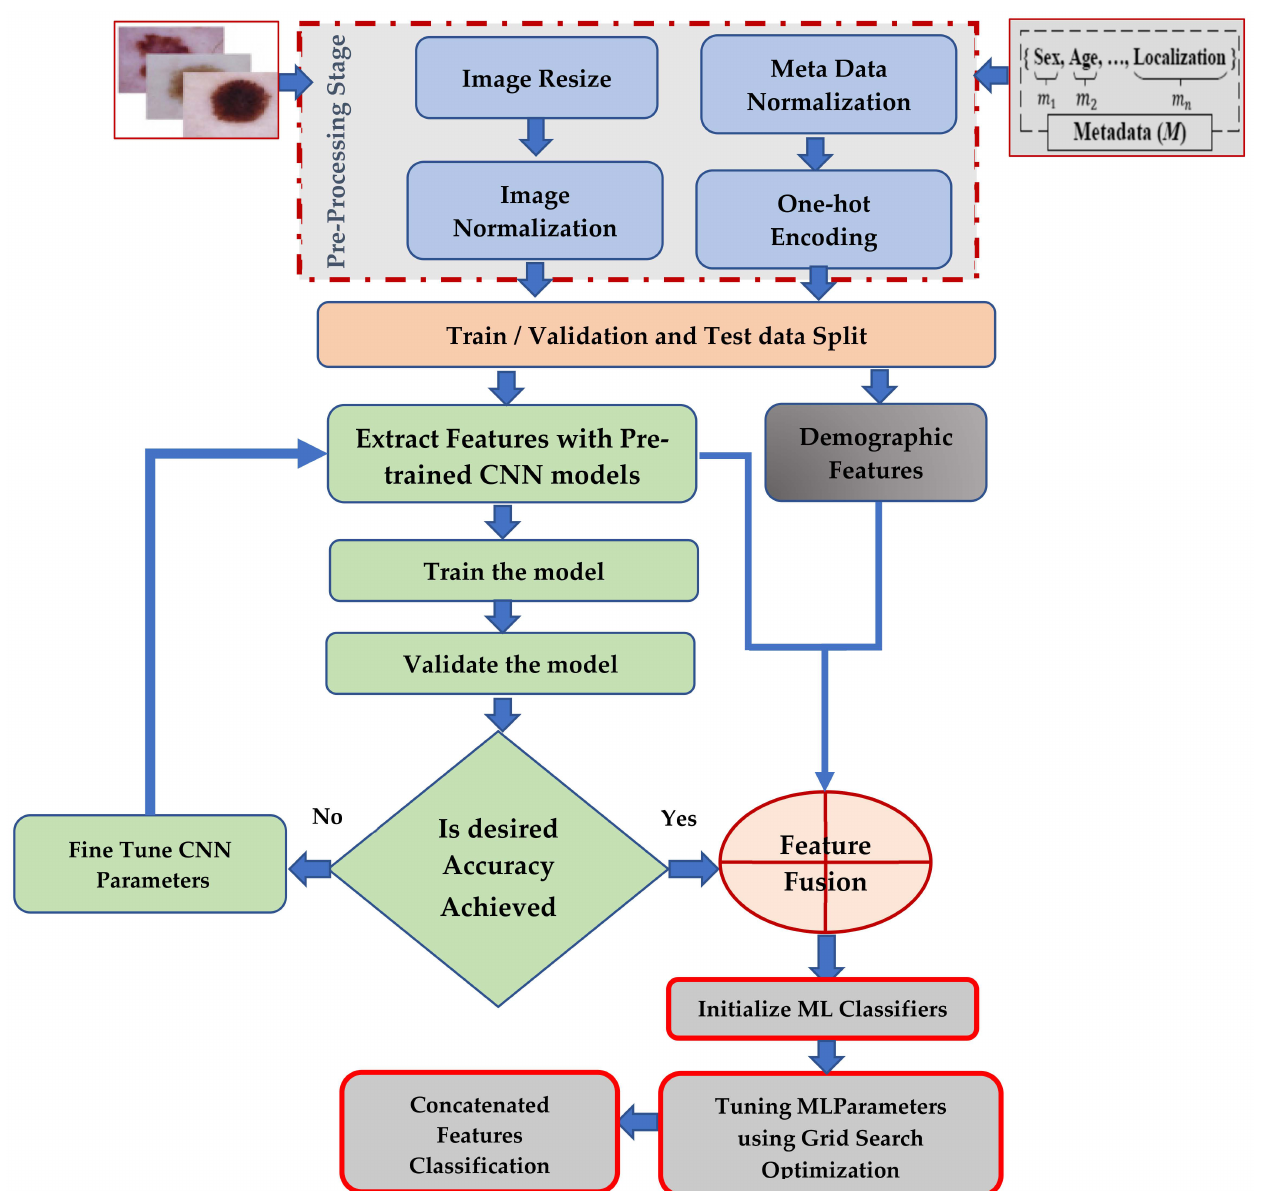
Figure 2. The pipeline of the proposed ensemble feature fusion approach for skin disease